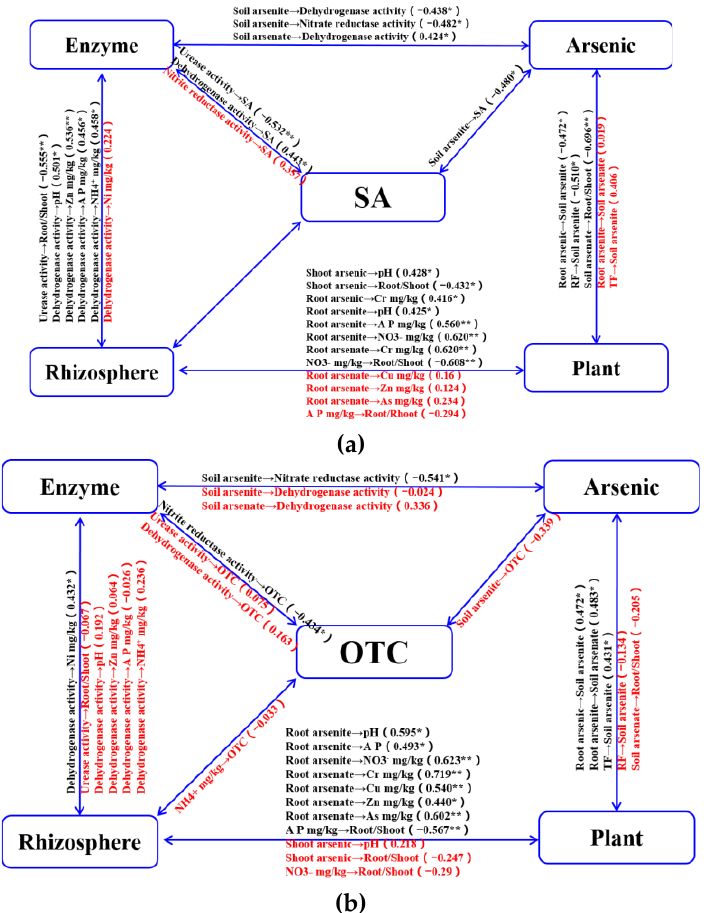
Figure 5. Relationships among biogeochemical processes of ecosystems and antibiotics treatments. ( a ) Relationships among biogeochemical processes of ecosystems and SA treatments; ( b ) Relationships among biogeochemical processes of ecosystems and OTC treatments. OTC is the oxytetracycline treatment; SA is the sulfadiazine treatment; A P is the concentration of soil available phosphorus; NH 4+ stands for soil ammonium nitrogen concentration; NO 3 − represents the soil nitrate nitrogen concentration; TF (translocation factor) is a ratio of arsenic concentrations in plant shoots to arsenic concentrations in plant roots; BF (bioconcentration factor) is a ratio of arsenic concentrations in plant roots to arsenic concentrations in soil; * or ** represents significant correlation ( p < 0.05 or p < 0.01). The black letters represent significant differences between biogeochemical processes and rhizosphere antibiotic treatment relationships in ecosystems, while the red letters represent no significant differences.